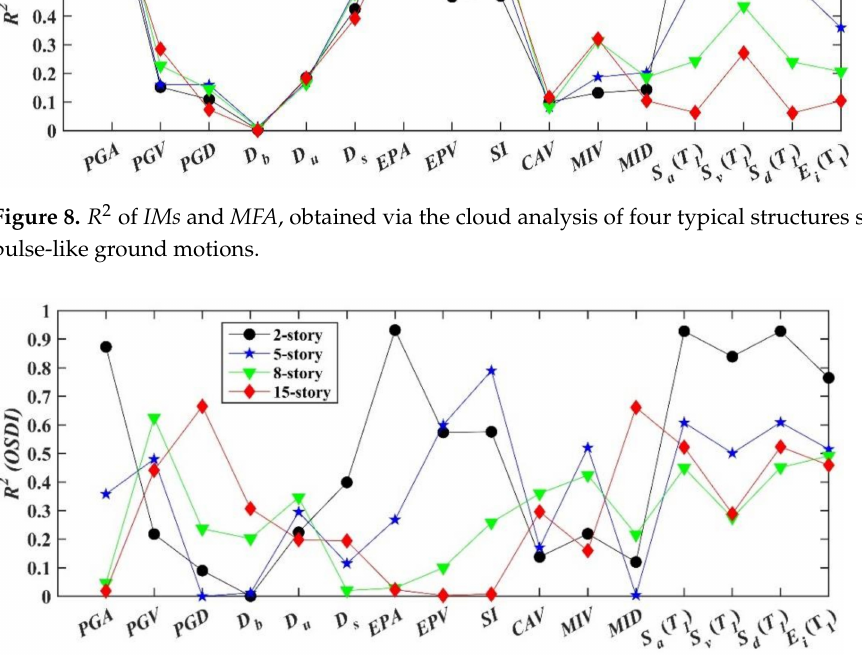
Figure 9. R 2 of IMs and OSDI , obtained via the cloud analysis of four typical structures subjected to pulse-like ground